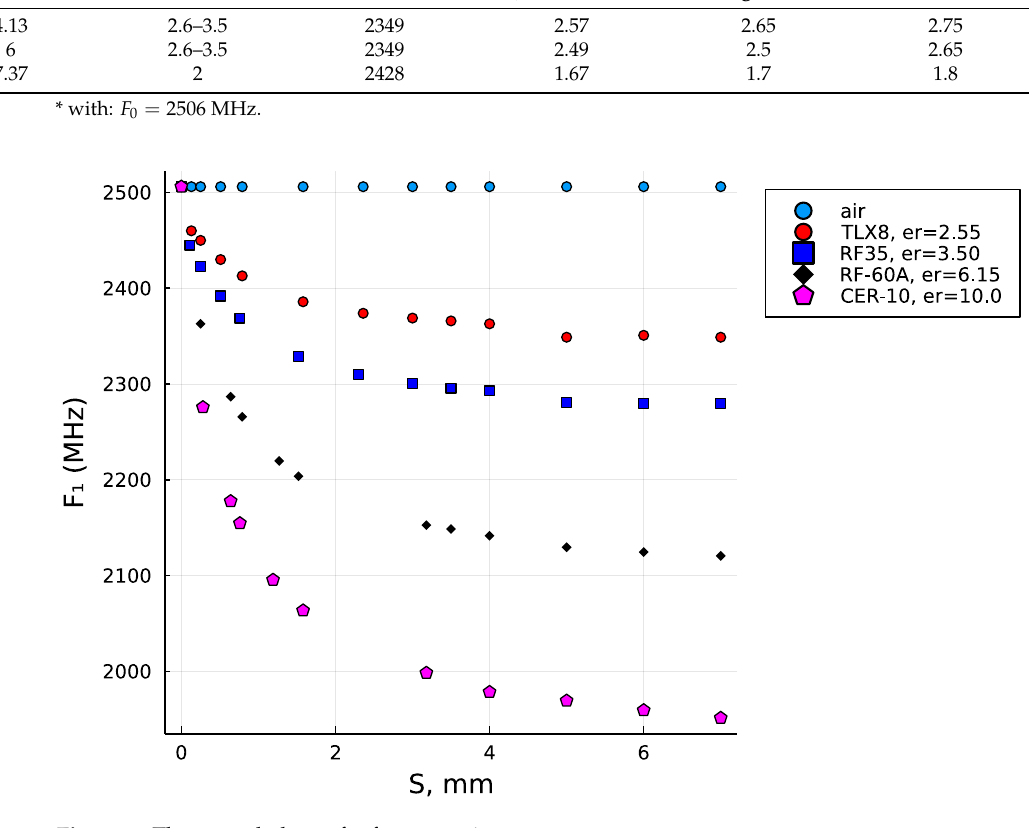
Figure 7. The extended set of reference